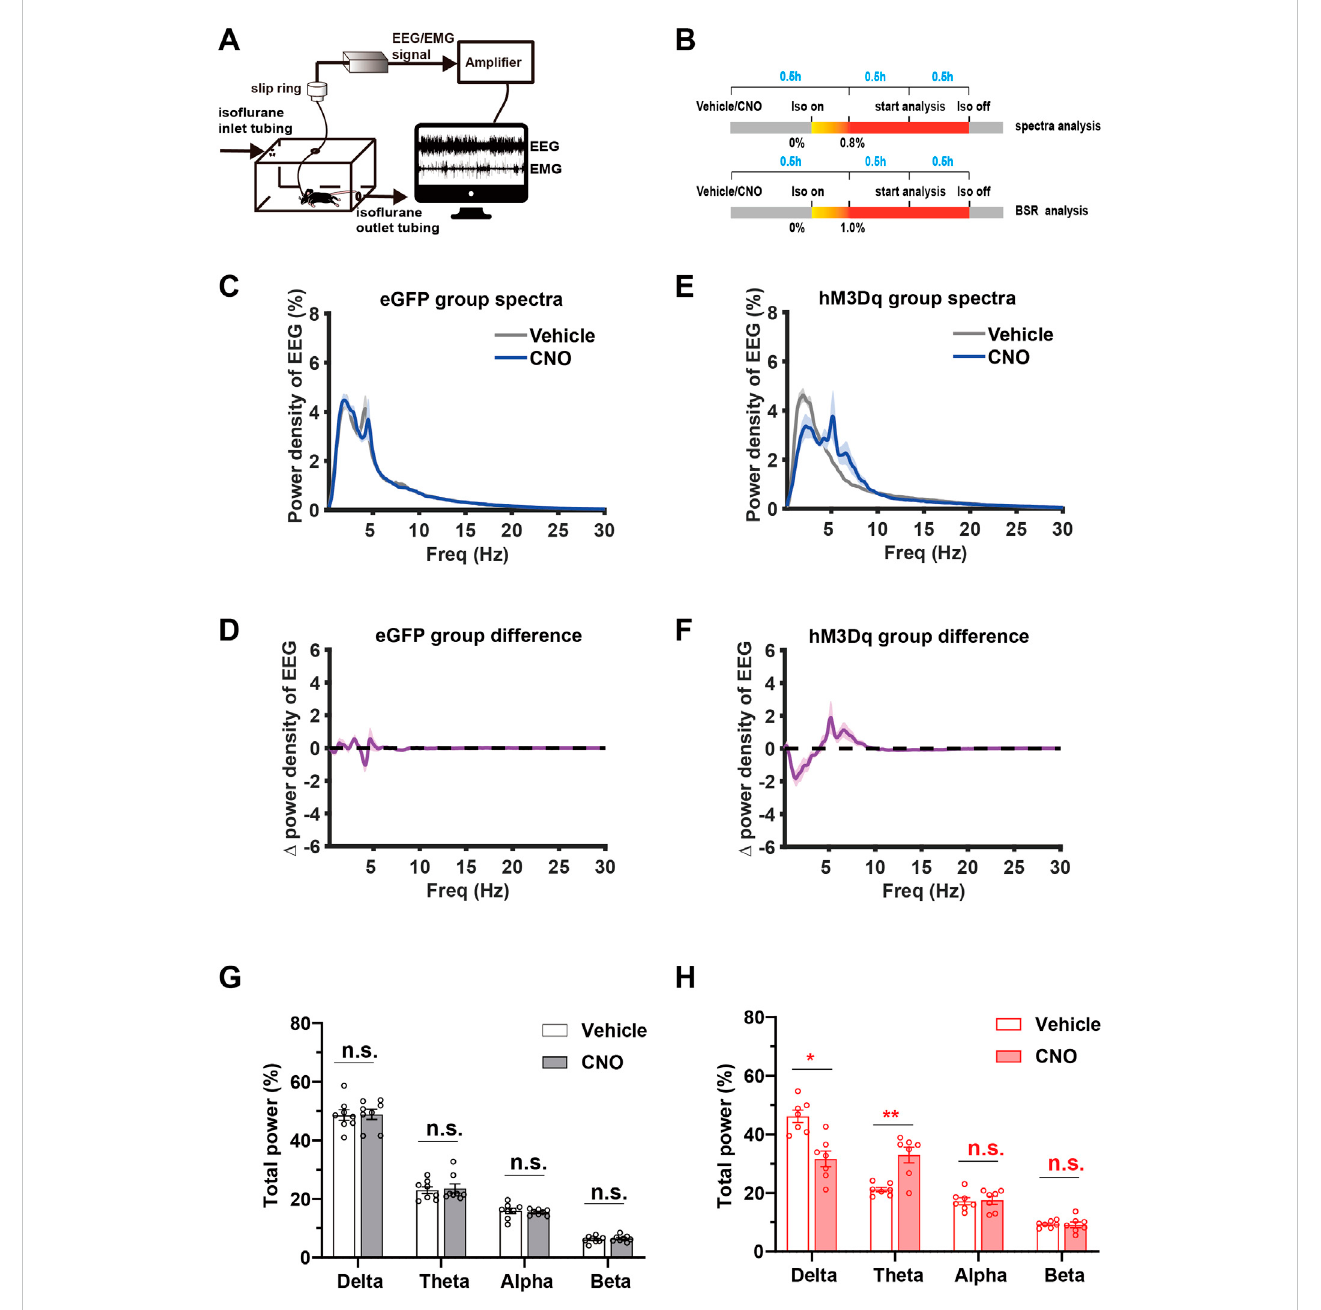
FIGURE 4 Chemogenetic activation ofPBNastrocytespromotes cortical activityduringiso fl uraneanesthesia (A) SchematicdiagramofEEG/EMGrecordingduring iso fl uraneanesthesia. (B) Schematicdiagramofexperimentalprotocolfor observing theeffectof activation ofPBNastrocytes on EEG spectrumpower under .8% iso fl uraneanesthesiaand BSR under1.0% iso fl uraneanesthesia. (C) Normalized power densities of EEG signals in theeGFP group after injection of vehicle or 3 mg/kg CNO. Shadow areas represent mean ± SEM ( n = 8). (D) Differences in power densities of EEG signals in the eGFP group after injection of the vehicle and 3 mg/kg CNO. Shadow areas represent mean ± SEM ( n = 8). (E) Normalized power densities of EEG signals in hM3Dq group after injection of the vehicle or 3 mg/kg CNO. Shadow areas represent mean ± SEM ( n = 7). (F) Differences in power densities of EEG signals in the hM3Dq group after injection of the vehicle and 3 mg/kg CNO. Shadow areas represent mean ± SEM ( n = 7). (G) Relative EEG power after vehicle or 3 mg/kg CNO injection in the eGFP group during.8%iso fl uraneanesthesia.Paired t -test( n =8). (H) RelativeEEGpoweraftervehicleor3 mg/kgCNOinjectioninthehM3Dqgroupduring.8%iso fl urane anesthesia. Paired t -test ( n = 7). Values represent mean ± SEM; * p < .05 or ** p < .01 shows signi fi cant differences between the vehicle and experimental groups. EEG, electroencephalogram; EMG, electromyogram; BSR, burst suppression